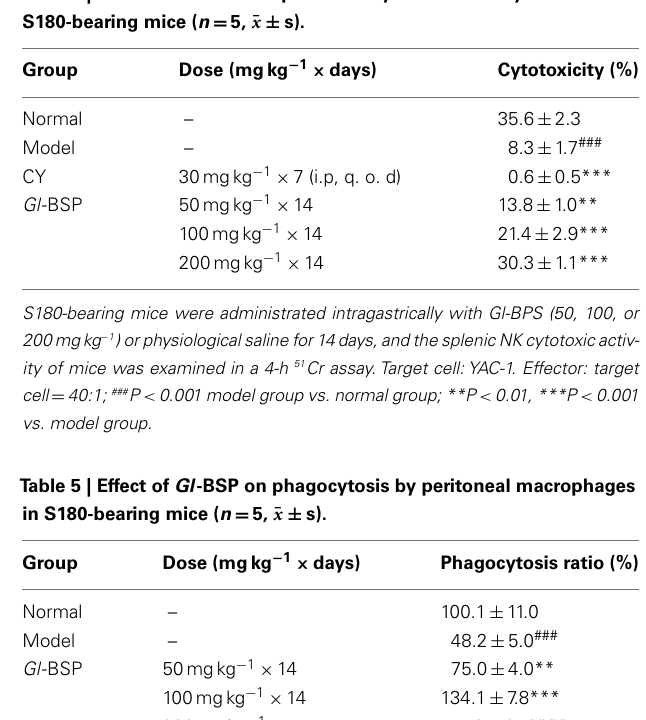
Table 3 | Effect of Gl -BSP on spleen lymphocyte proliferation induced